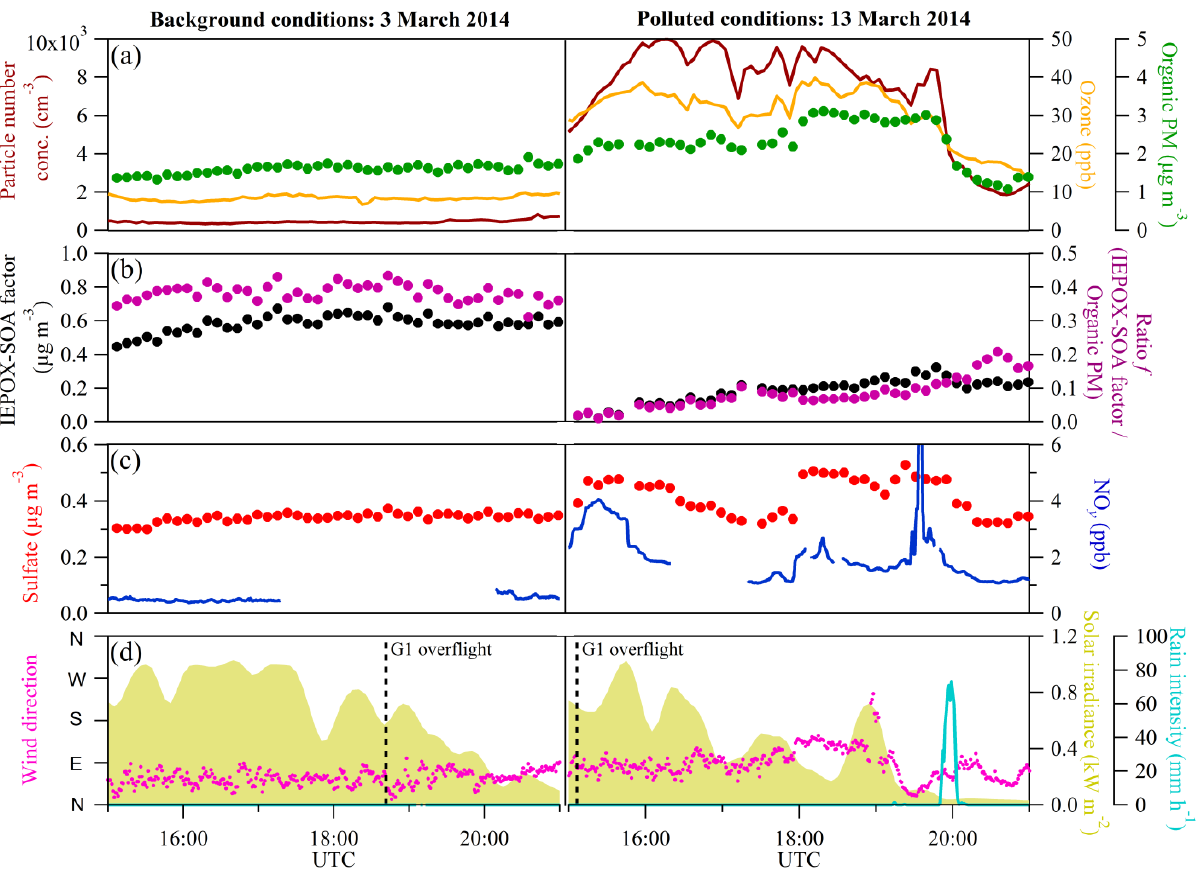
Figure 4. Case studies of (left) background and (right) polluted air masses passing over T3 on afternoons of 3 and 13 March 2014. (a) Ozone, particle number, and organic mass concentration. (b) IEPOX-SOA factor loading and the ratio f of the factor loading to the organic PM concentration. (c) Sulfate and NO y concentrations. (d) Wind direction, rain intensity, and solar irradiance. Local time is UTC − 4h. Time points of overflights at 500m by the G-1 research aircraft are marked by the dashed line (Martin et al.,